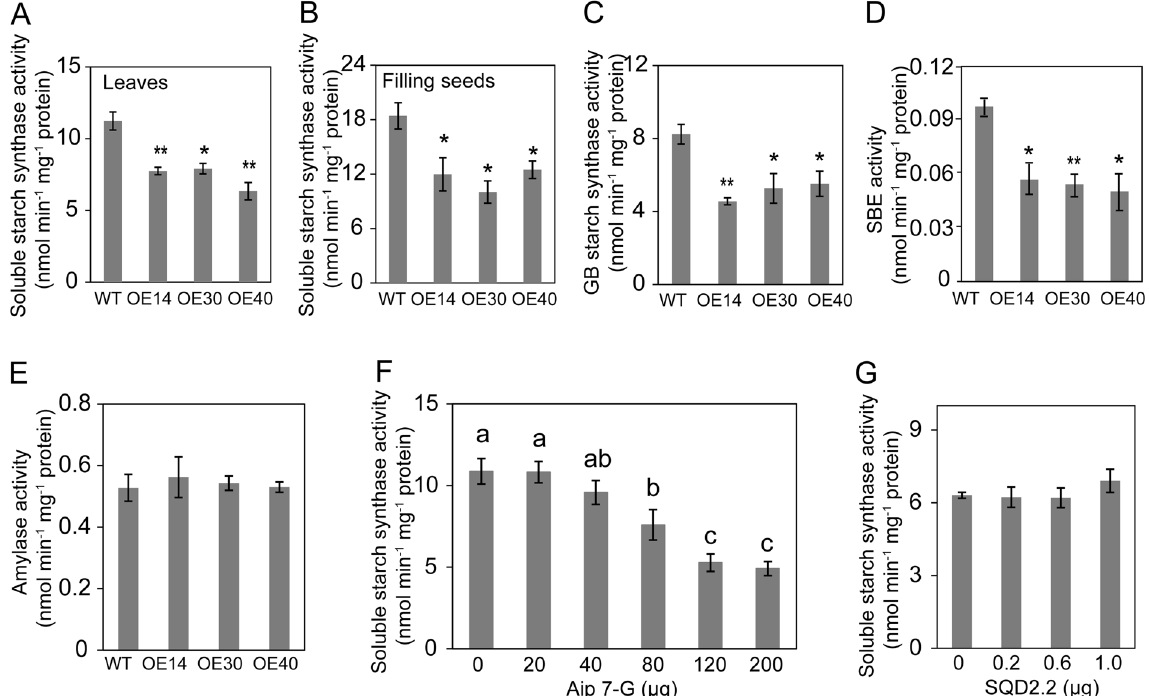
Figure 6. Apigenin 7-O-glucoside inhibited starch synthase activity, and overexpression of SQD2.2 resulted in reduced starch synthase activity. ( A ) and ( B ) Soluble starch synthase activity in the leaves and filling seeds of SQD2.2 -OE was significantly lower than in that in WT plants. Proteins were extracted from leaves at the tillering stage and extracted from the filling seeds 15 days after anthesis. The same amount of protein (100 μ g) from both SQD2.2 -OE and WT plants was added to the reaction mixture. Values are the mean ± SE (n = 6). ( C ) to ( E )The activities of granule-bound (GB) starch synthase ( C ), starch branching enzyme (SBE) ( D ) and amylase ( E ) in leaves of SQD2.2 -OE and WT plants. Proteins were extracted from leaves at the tillering stage. Values are the mean ± SE (n = 6). ( F) Apigenin 7-O-glucoside, the product of SQD2.2, inhibited soluble starch synthase activity in a concentration-dependent manner. Proteins were extracted from the leaves of one-month- old WT plants. Values are the mean ± SE (n = 3). Different letters (a, b and c) indicate significant differences at P < 0.05, according to ANOVA analysis and Duncan’s multiple range test. Api 7-G, apigenin 7-O-glucoside. ( G ) SQD2.2 itself did not inhibit soluble starch synthase activity. Proteins were extracted from the leaves of one- month-old WT plants and were treated with purified SQD2.2 protein in various concentrations. Values are the mean ± SE (n = 3). Student’s t test; * P < 0.05, ** P <